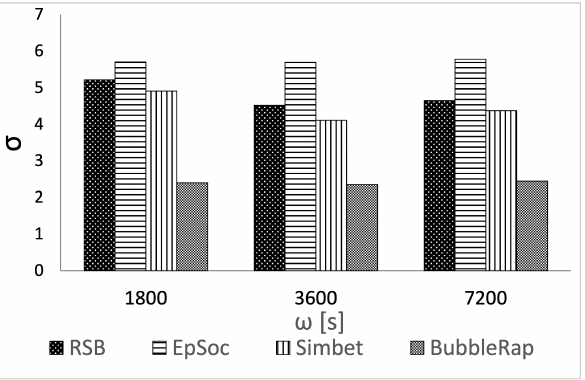
Figure 10. Hops average ( σ ) as a function of the message generation interval ( ω